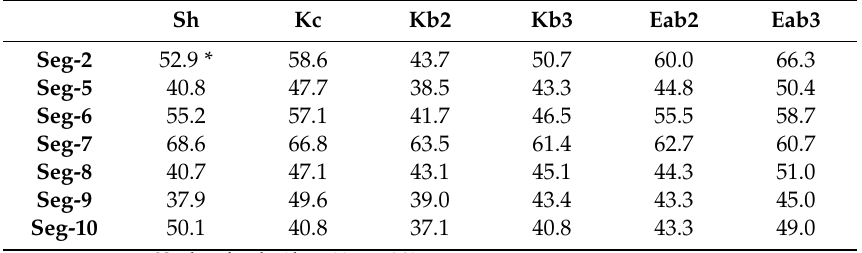
Table 2. Genetic diversity of BTV-3 from infectious sheep blood and cell-culture-passaged viruses. Sh Kc Kb2 Kb3 Eab2